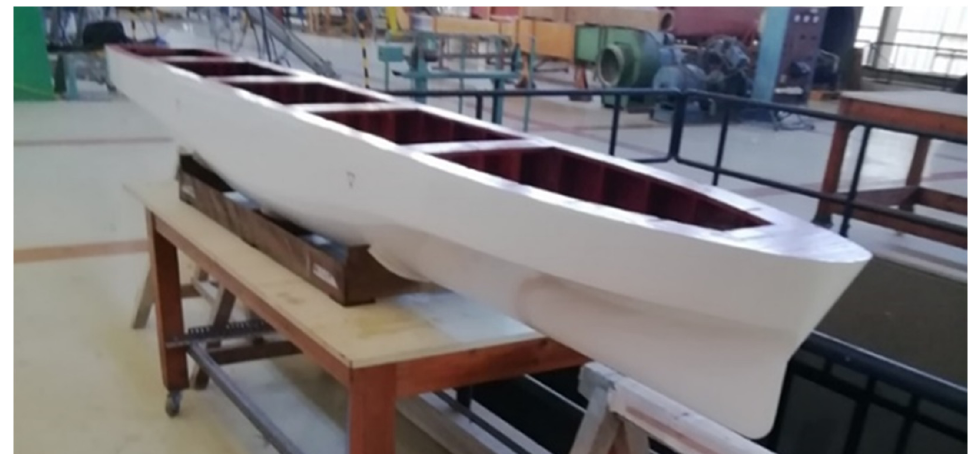
Figure 2. NTUA tank-scale ferry hull model of L/B = 7.67 used for tests. The model is tested without and with the operation of a biomimetic dynamic wing.